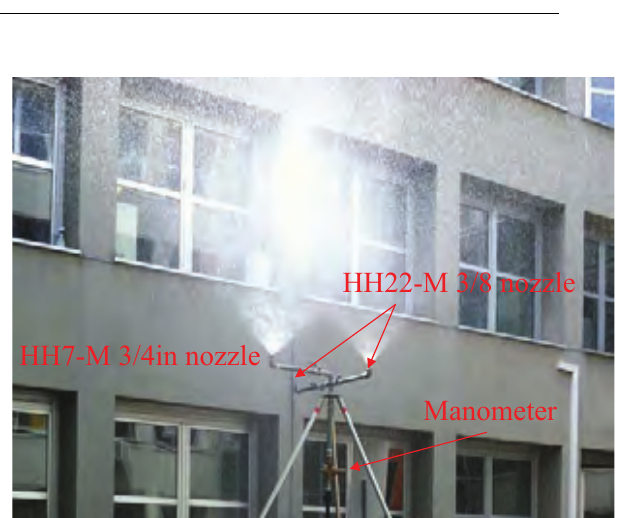
Fig. 4. View of the rainfall simulator. Water jets are sprayed from two HH22-M 3/8 in and one HH7-M 3/4 in nozzles. surface reflections, and extraneous objects and litecnico di Milano based on the prototype by (Riley and Hancock, 1997). The basic structure of the simulator com- prises a telescopic aluminum tripod connected to a steel plate. Three hoses are riveted to the plate and water is sprayed through a system of three nozzles as displayed in Figure 4. Specifically, an HH7-M 3 = 4in nozzle is mounted on the central hose whereas two smaller HH22-M 3 = 8in noz- zles are placed onto the lateral hoses. Three cut-off valves allow for selectively activating the nozzles and controlling rainfall intensity. Water is supplied to the hoses through a